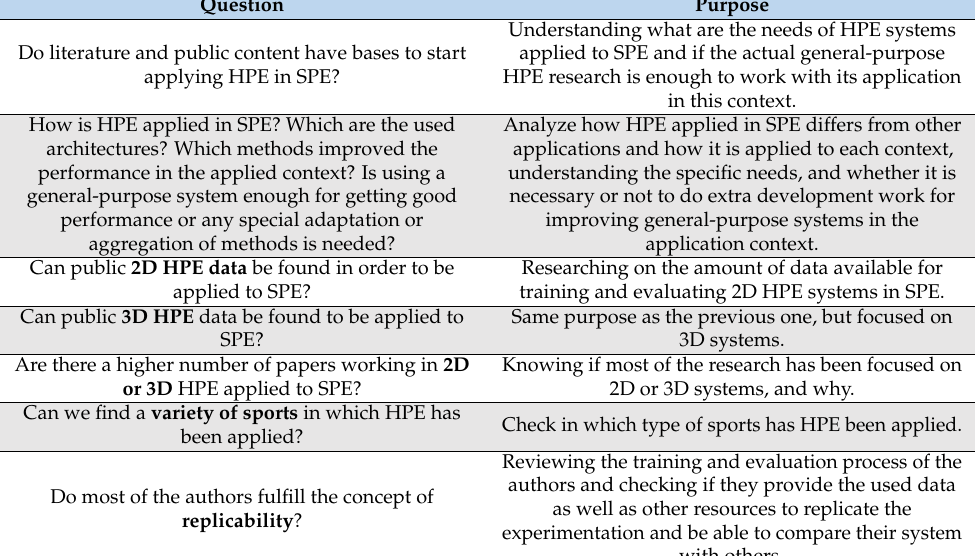
Table 1. Research